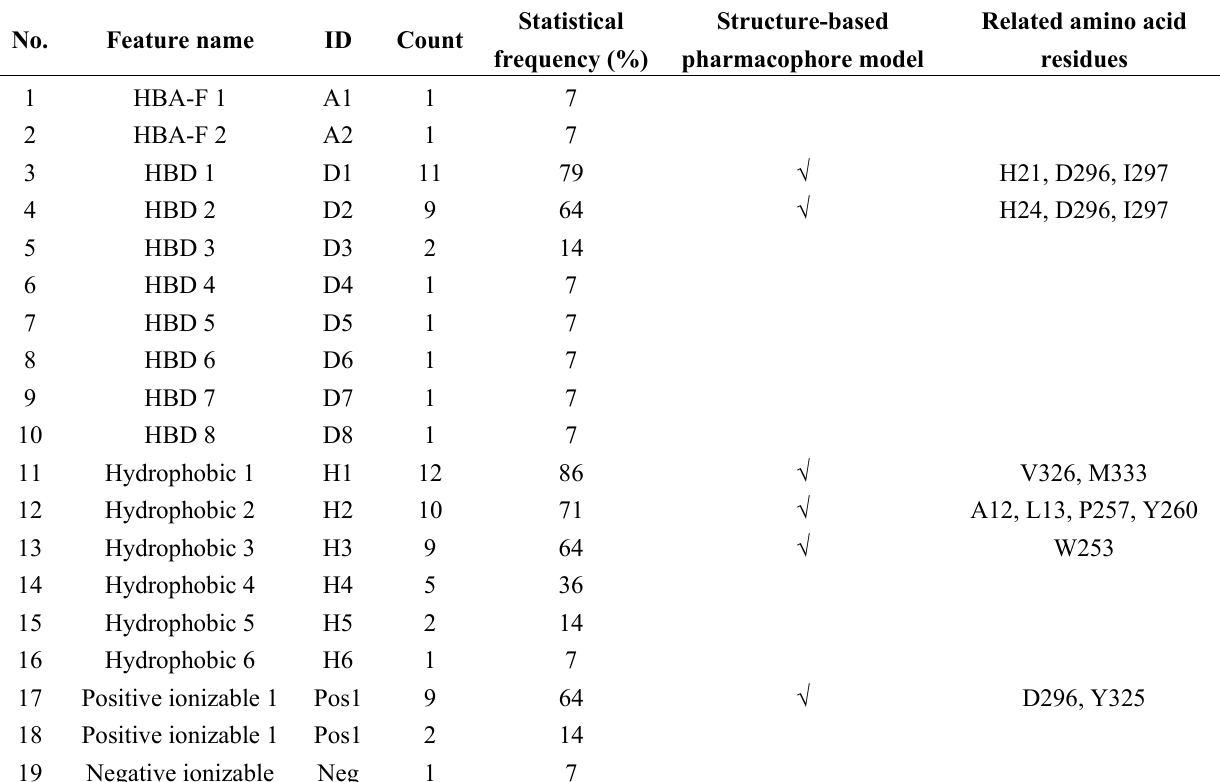
Table 1. Analysis and comparison of pharmacophore model